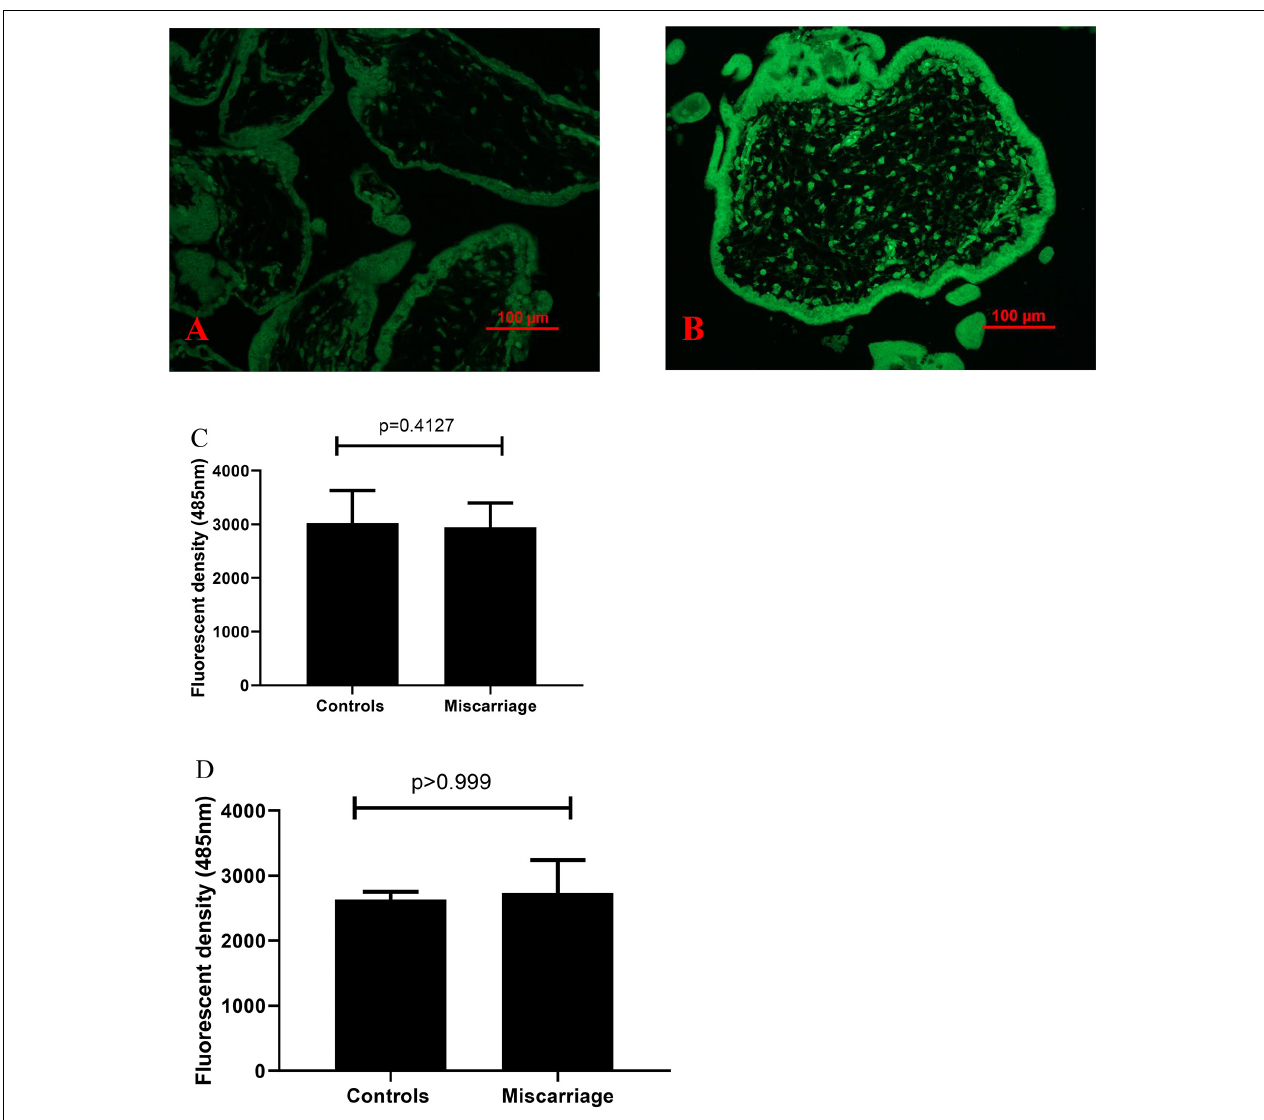
FIGURE 4 | Representative fluorescent compound ThT staining image of a thin section of a placenta showing that the intensity of ThT (green) was increased in placentas from missed miscarriage (B) compared to healthy first-trimester placentas (A) . ThT fluorescent intensity analysis showing no changes in fluorescent intensity in both placental micro-EV [ (C) , p = 0.4127] and nano-EVs [ (D) , p > 0.999] collected from women with missed miscarriage or controls.